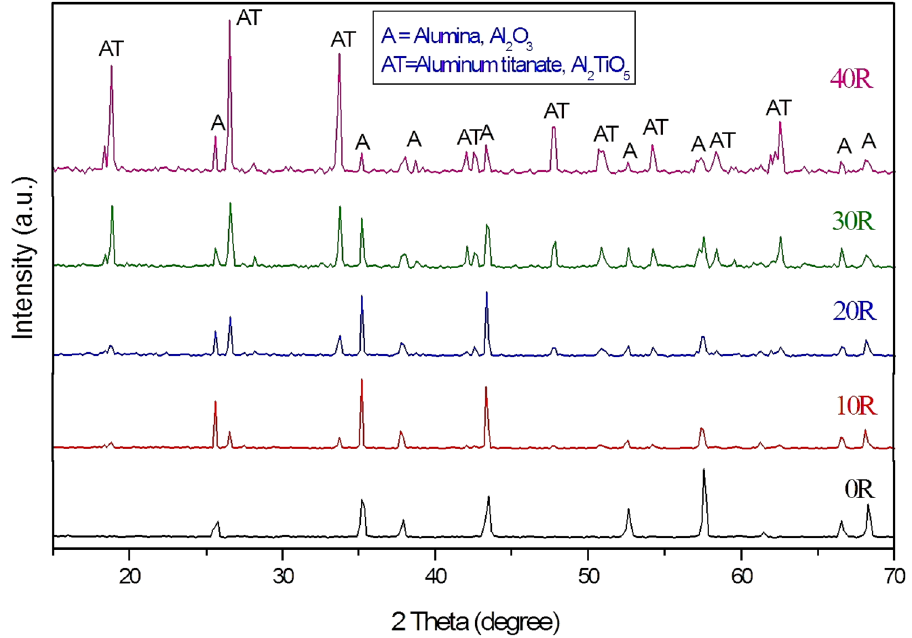
Figure 2. XRD pattern of the sintered A/AT composites with different rutile content (0–40